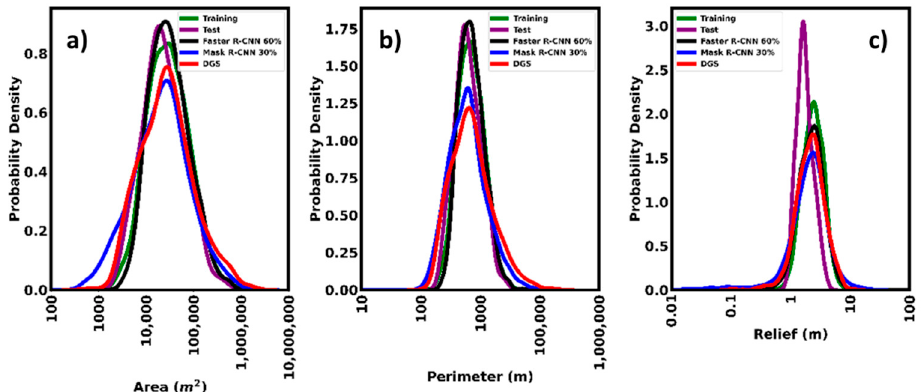
Figure 9. Kernel density estimation for ( a ) area ( b ) perimeter, and ( c ) maximum relief for the Delaware training and test annotations, Delaware Faster R-CNN detection at 60%, Delaware Mask R-CNN detections at 30%, and existing data from DGS. Table 2. Area, perimeter, and max. relief middle quartiles for annotations and detections from Delaware.